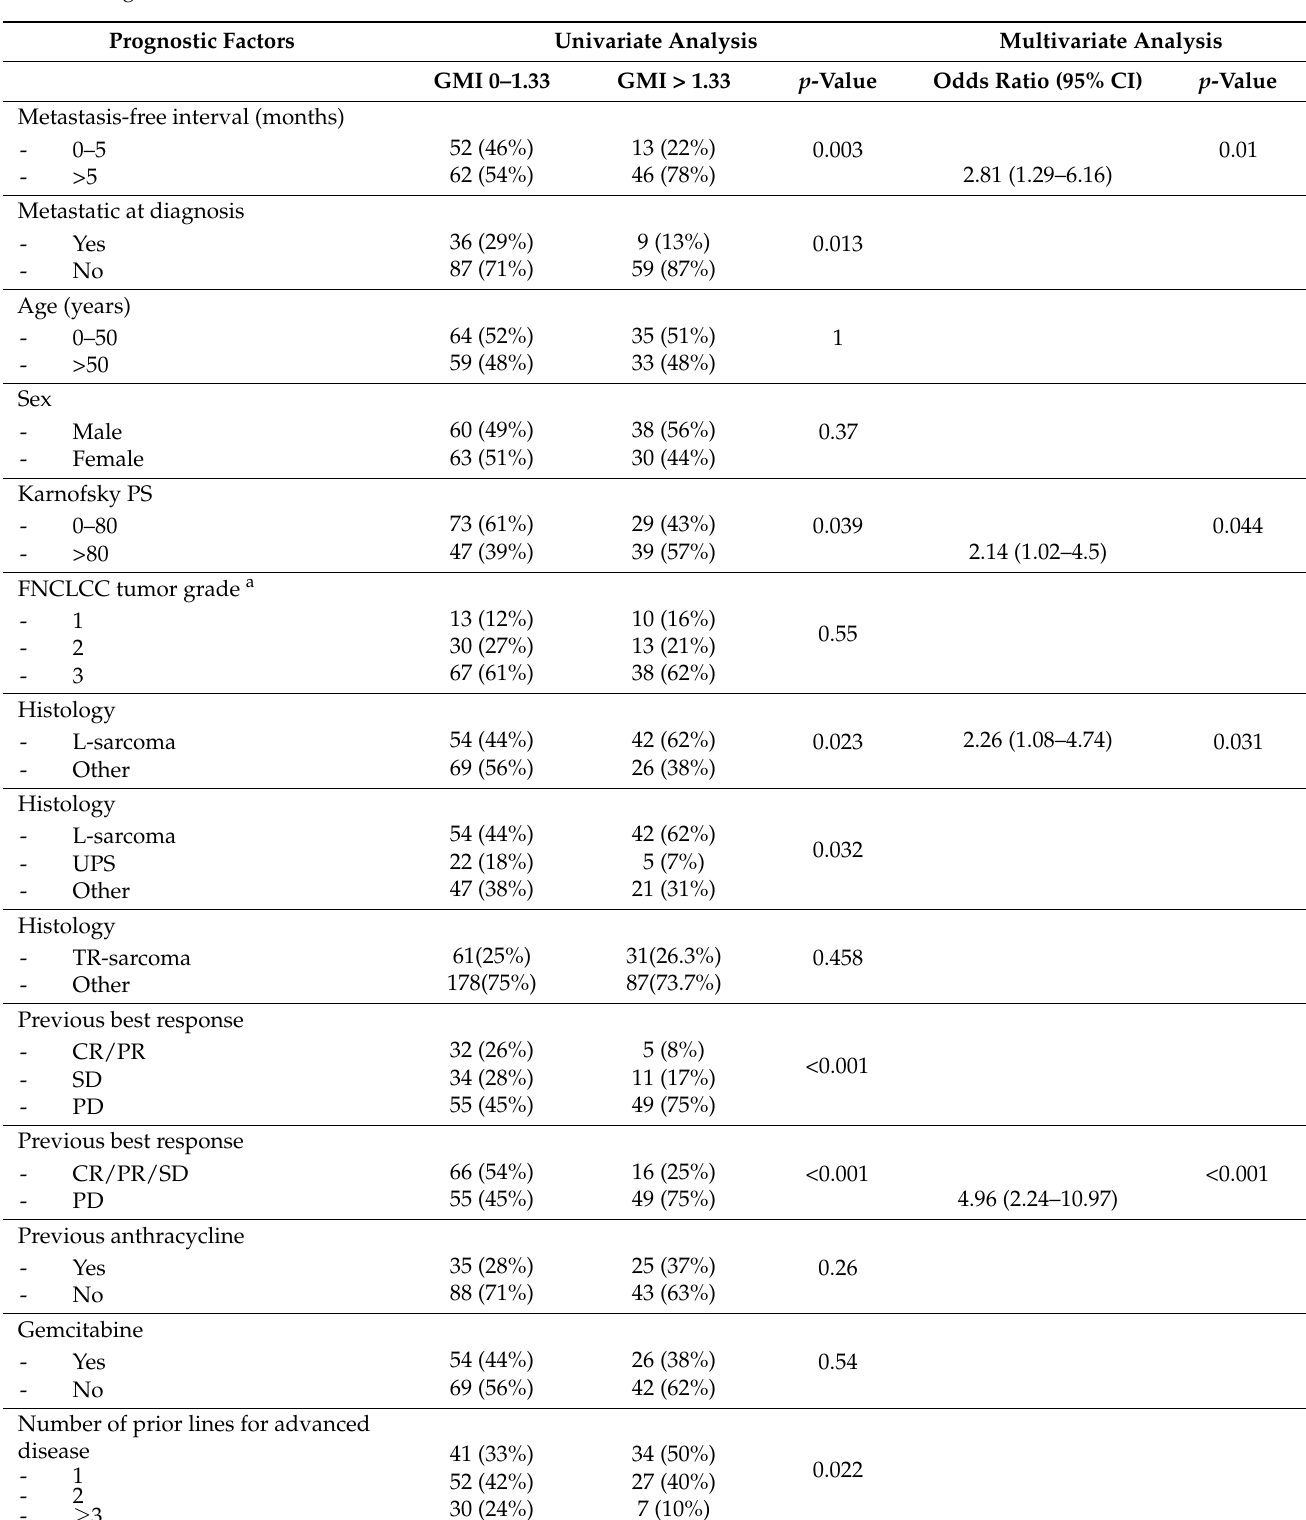
Table 4. Univariate and multivariate analysis of variables in relation to growth modulation index (GMI) in the training